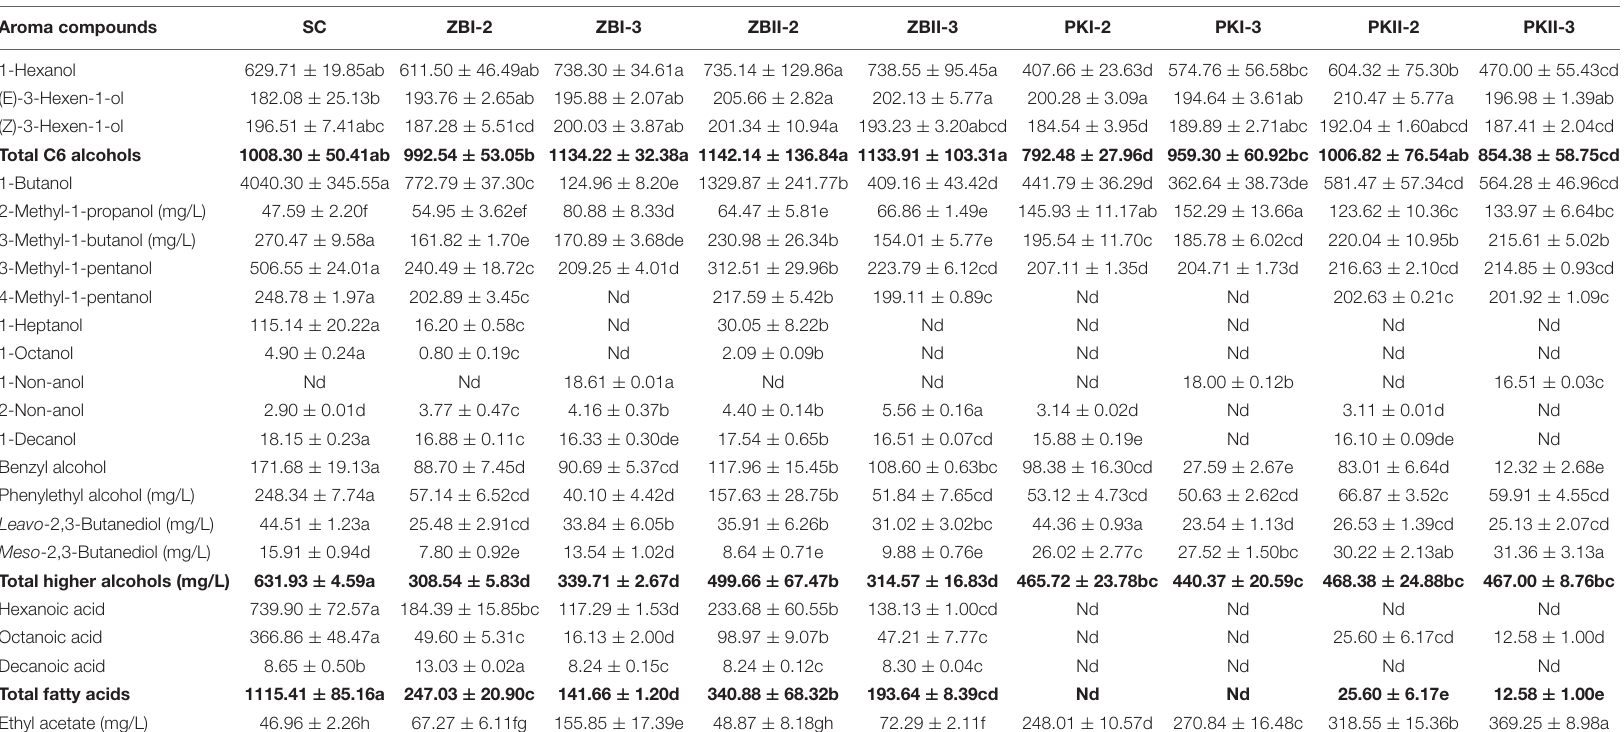
TABLE 2 | Volatile composition ( µ g/L) of the final wines after alcoholic fermentation. Aroma